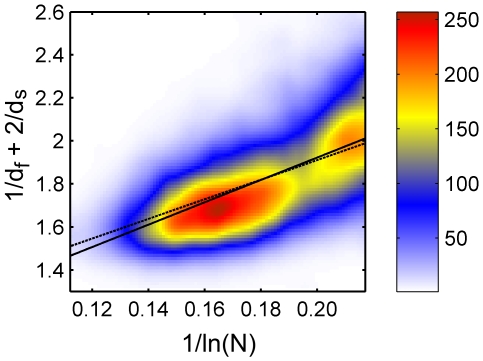
Full data set for  Å, colored histogram.The values of  against  plotted for the full data set (5793 proteins) with  Å. The data is presented using a smoothed colored histogram based on a  grid, see the color scale on the right (low density areas colored blue and high density red). The data was fitted to Eq. (3) (dashed line) and to Eq. (4) (full line).